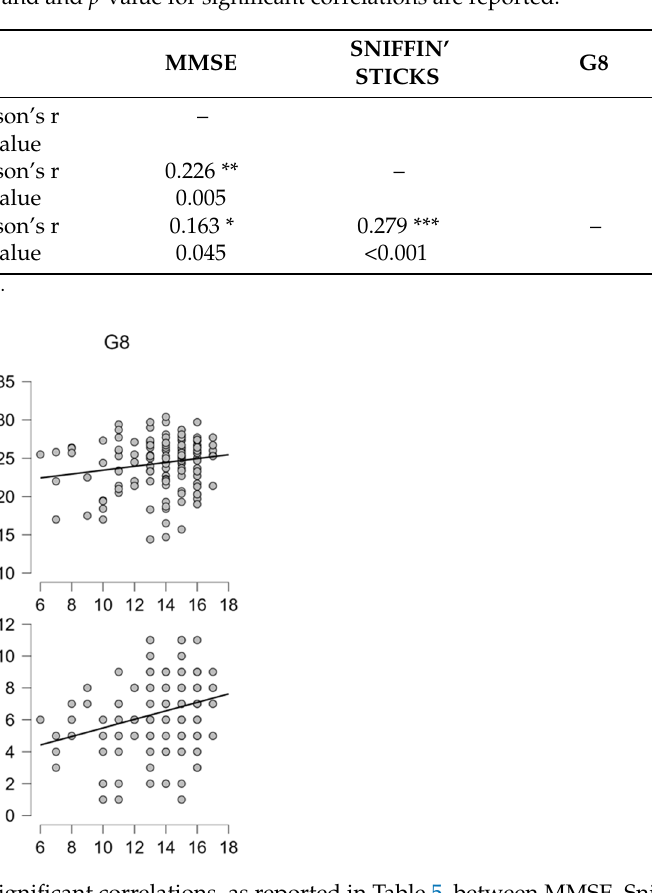
Figure 4. Scatterplots show significant correlations, as reported in Table 5, between MMSE, Sniffin’